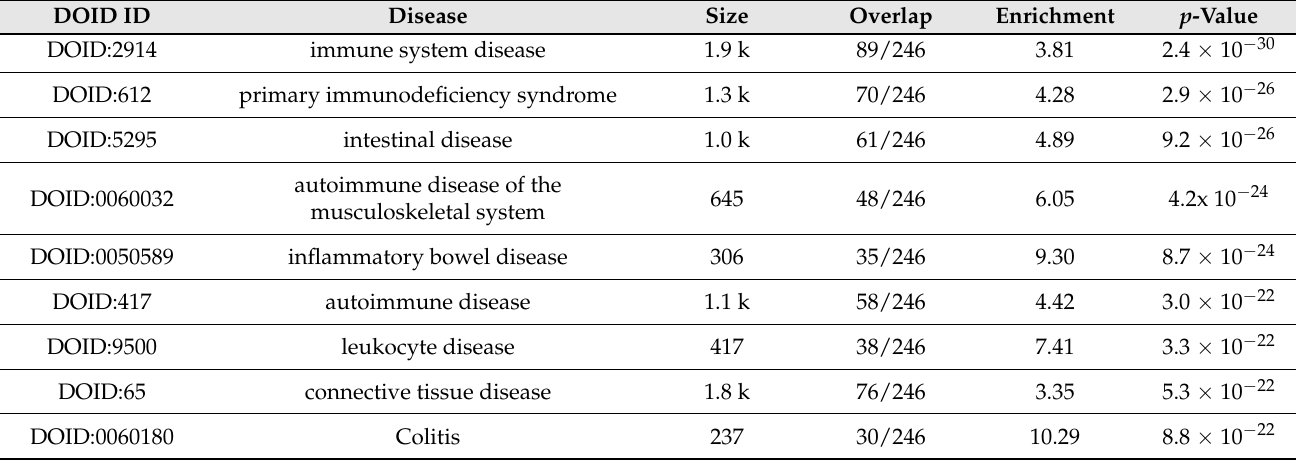
Table 3. Results of inBio Discover annotation analysis with the DOID disease annotations classification in first episode psychosis and schizophrenia.